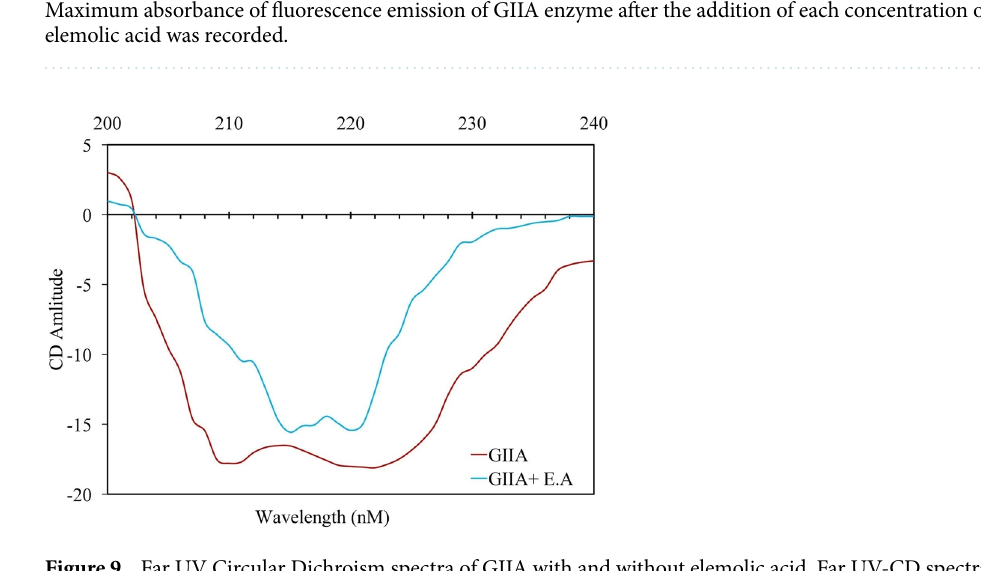
Figure 9. Far UV Circular Dichroism spectra of GIIA with and without elemolic acid. Far UV-CD spectra were recorded between 200 and 240 nm on a Jasco J715 spectropolarimeter. ( a ) UV-CD spectra of GIIA (30 µg/mL) alone, and ( b ) GIIA with IC 50 concentration of elemolic